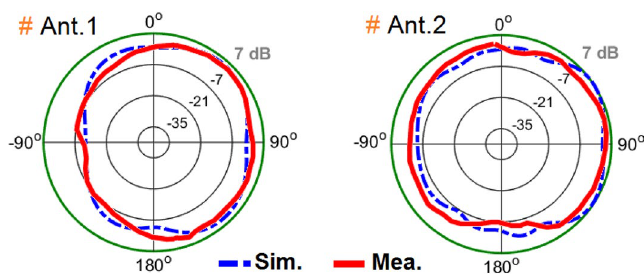
Figure 13. Measured and simulated data of two antenna elements’ radiations (E-Plane).